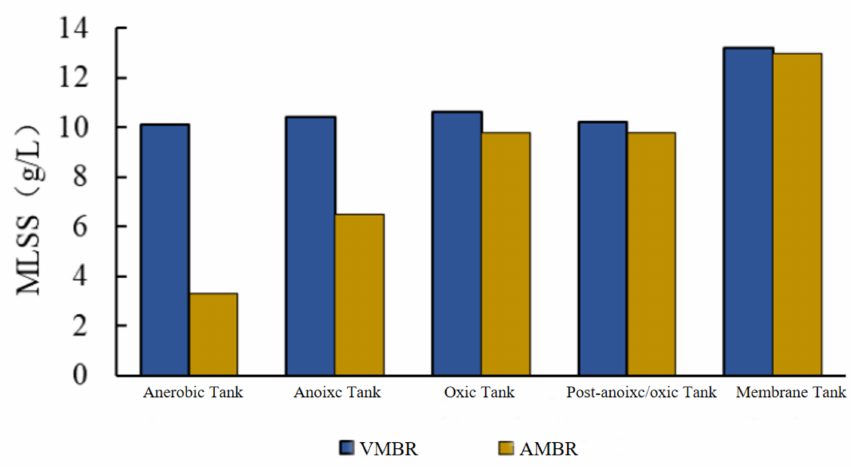
Figure 9. The MLSS of VMBR and